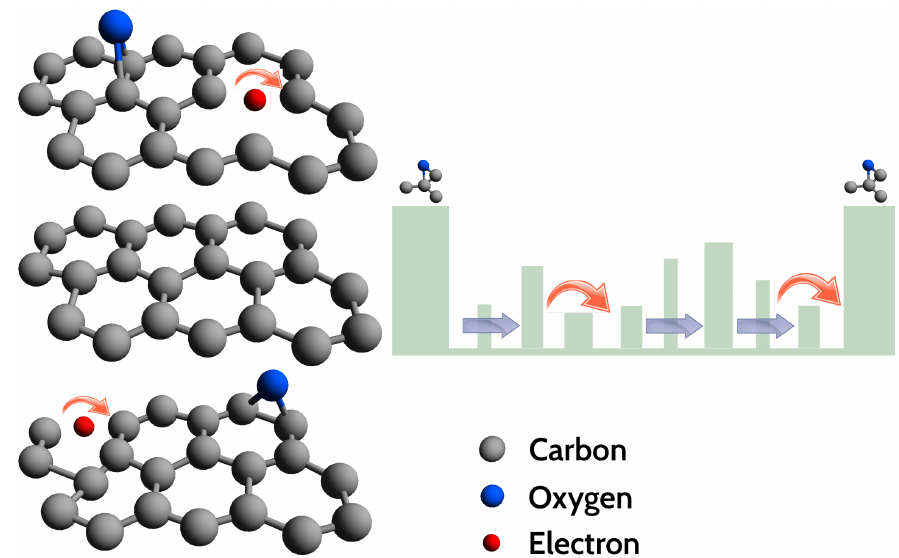
Figure 11. ( Left ): schematic illustration of the investigated graphene sponge structure, here assumed as formed by a build up of graphene-like planes, containing some defects and bridge bonded oxygen. ( Right ): VRH conduction of electrons trapped inside a large potential well created by the bonded oxygen. Charge carriers hop (red arrows) between two localised levels created by various defects present in the graphene plane. Blue arrows show a possible tunnelling mechanism occurring in the